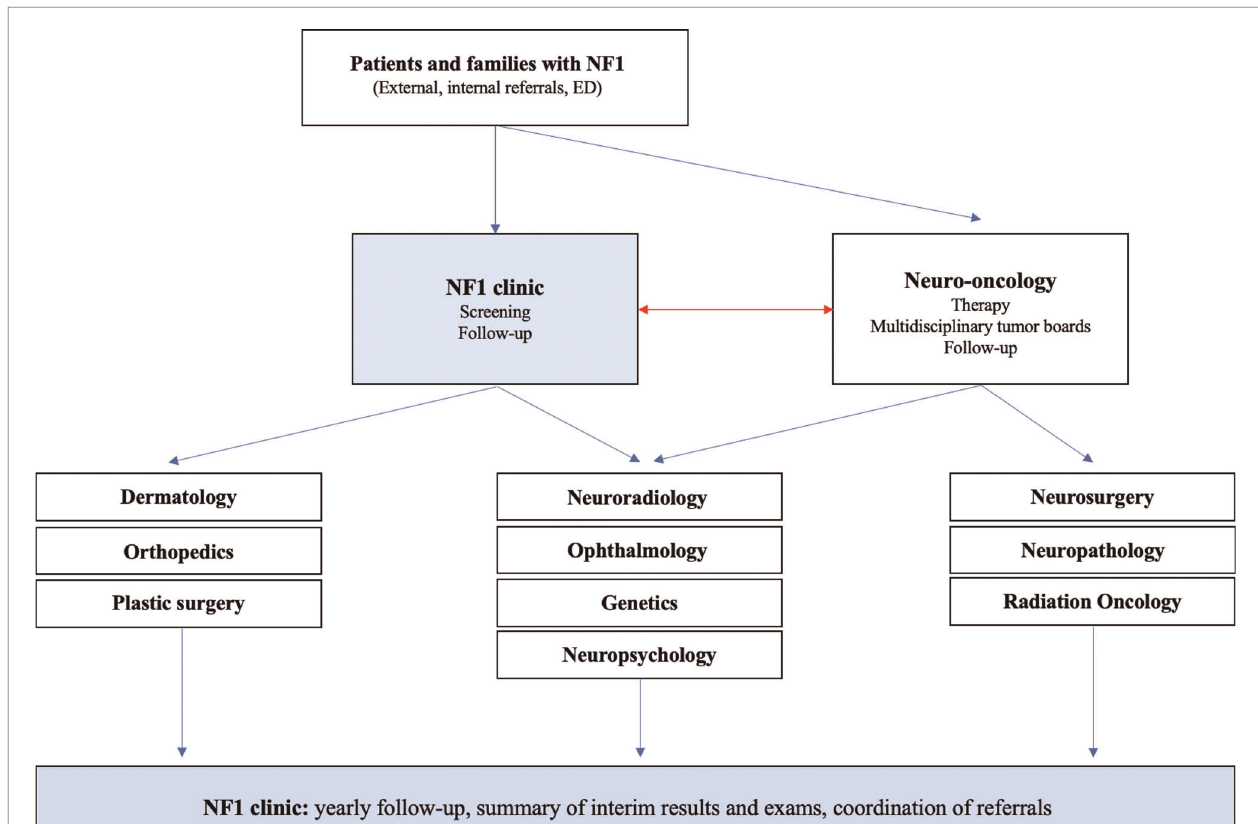
FIGURE 1 | Schematic drawing illustrating the functional network of care for children with NF and OPG at the Hospital for Sick Children. The NF clinic plays a central role in connection, coordination, and integration of directed care for these complex